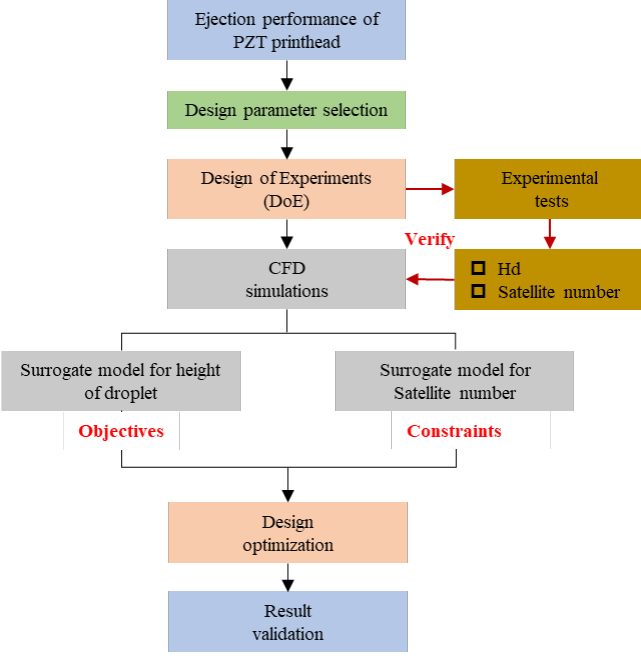
Figure 8. The process of surrogate modeling-based optimization.